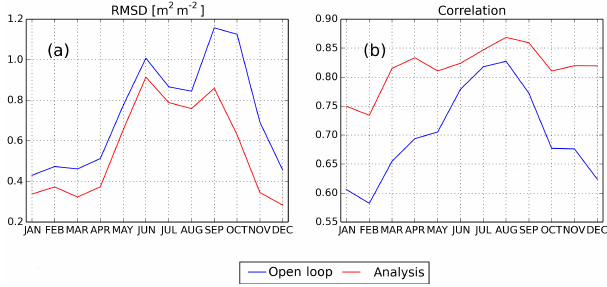
Figure 2. Seasonal (a) RMSD and (b) correlation values between leaf area index (LAI) from the open-loop, analysis and GEOV1 LAI estimates from the Copernicus Global Land Service project over